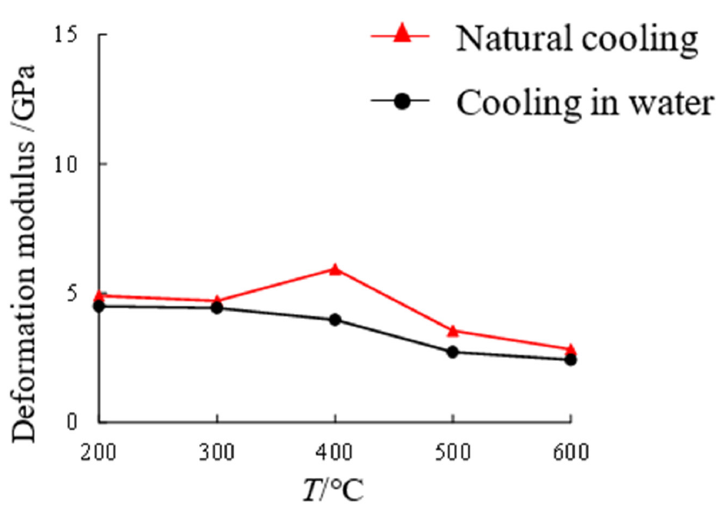
Figure 10. Change of deformation modulus of sample after different cooling methods.